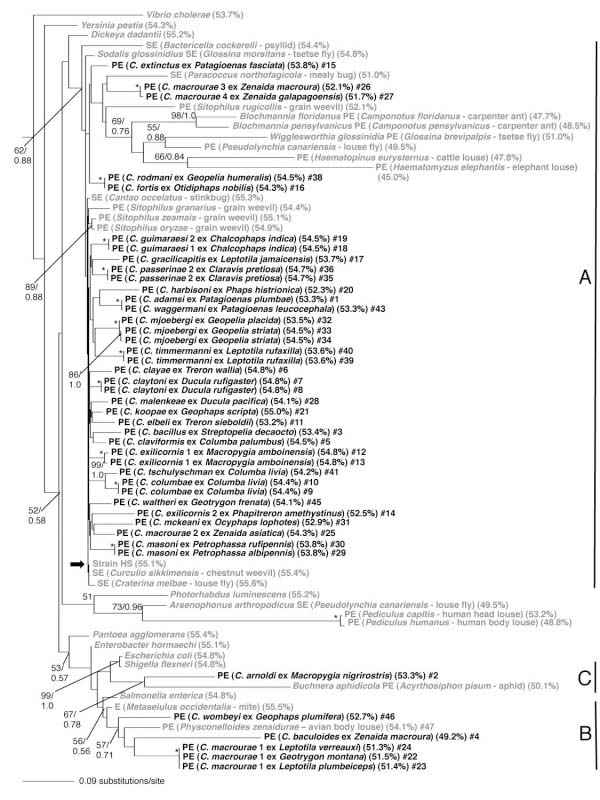
16S rRNA phylogeny of Columbicola spp. symbionts. Phylogeny of Columbicola spp. symbionts (bold) and related bacteria based on maximum likelihood and Bayesian analyses of a 1.46-kbp fragment of 16S rRNA gene sequences. Insect symbionts are designed by the prefix “PE” (primary endosymbiont), “SE” (secondary endosymbiont) or “E” (if unknown), followed by insect host name and common name (or latin name of bird host for Columbicola spp.) The numbers adjacent to nodes indicate maximum likelihood bootstrap values (to left of diagonal line) and Bayesian posterior probabilities, where applicable (to right of line), for nodes with bootstrap support >50% and Bayesian posterior probabilities >0.5. Asterisks indicate nodes with 100% bootstrap support and Bayesian posterior probability = 1. The bold arrow highlights the location of the sequence derived from strain HS, the recently characterized progenitor of the Sodalis-allied symbionts. Numbers in parentheses represent the G + C content of the 16S rRNA sequences. Final numbers correspond to sample numbers in Additional file 5.